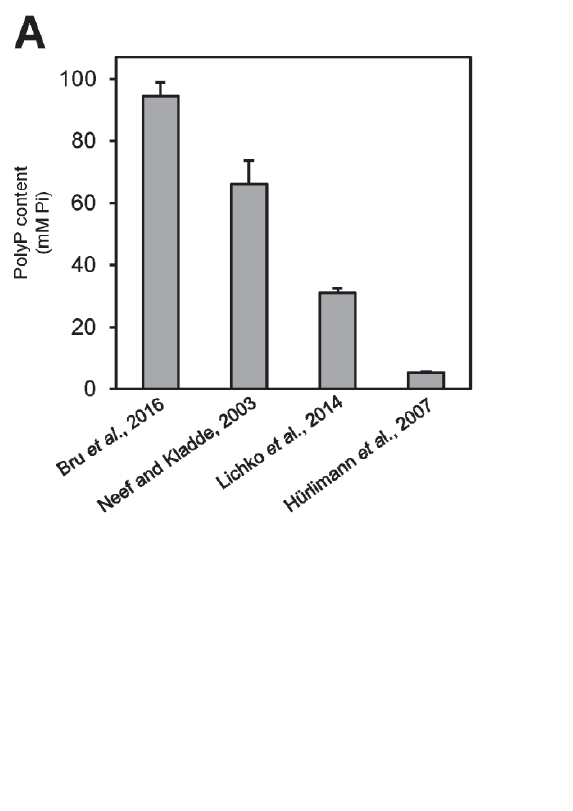
FIGURE 5 : Comparison of different polyP extraction and purifica- tion methods. (A) Amount of polyP corresponding to 10 7 logarith- mically growing yeast cells extracted and purified with the follow- ing methods: neutral-phenol/chloroform and ethanol precipitation [26], acid-phenol/chloroform and ethanol precipitation [33], per- chloric acid [23], and sulfuric acid and affinity columns [25]. Mean ± SEM from 3 independent experiments is shown. (B) Scheme of the polyP extraction and purification protocol using neutral phenol and ethanol purification. In brackets appears the figure supporting this particular step. For details and tips see Materials and